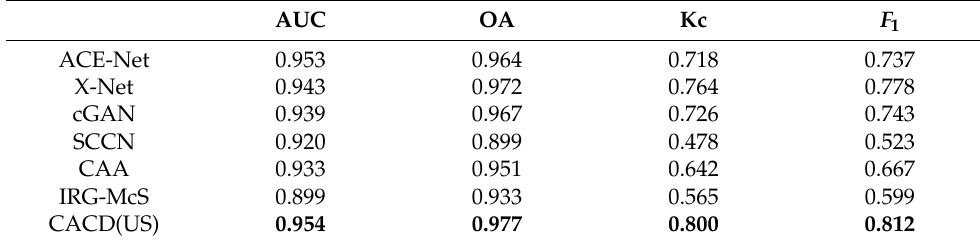
Table 3. Quantitative evaluation on the Sardinia dataset.